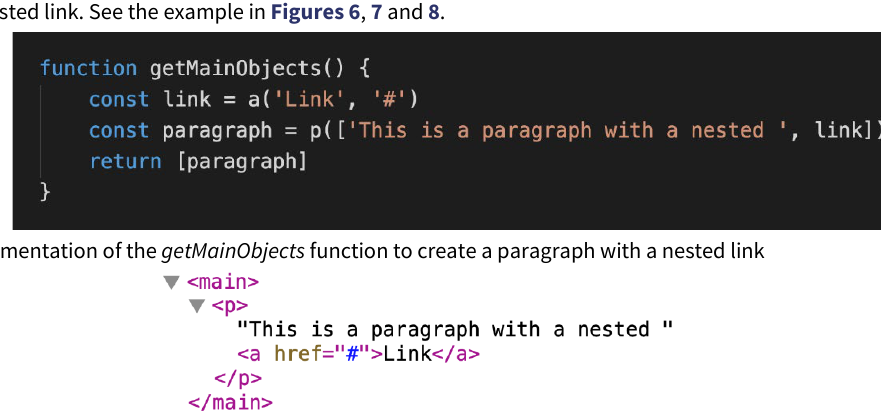
Figure 7. HTML code generated for the implementation of the getMainObjects function returning a paragraph with a nested link